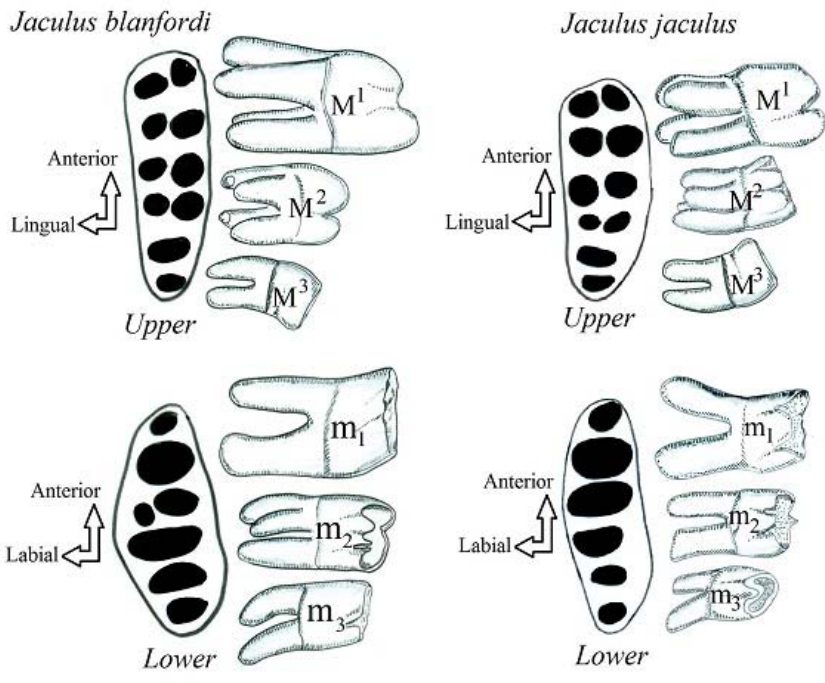
F IGURE 10. Variation of number of roots in upper and lower molars in Jaculus . Left: J. blanfordi and Right: J.